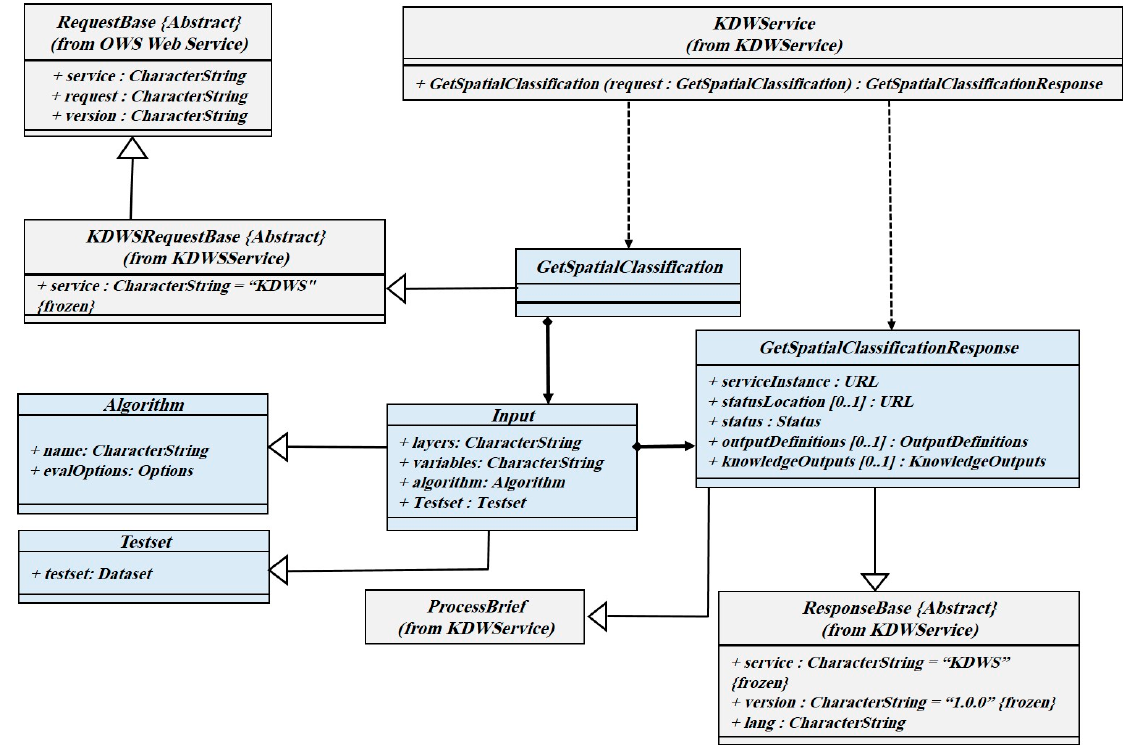
Figure 7. The interface of the GetSpatialClassification operation. ISPRS Int. J. Geo ‐ Inf. 2021 , 10 , x FOR PEER REVIEW